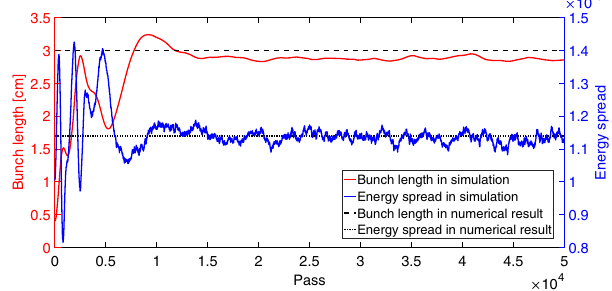
FIG. 6. Beam longitudinal parameters vary with the number of passes up to over 40000 turns, the red line stands for bunch lengths, while the blue one is energy spreads. The first dashed is the final bunch length derived from the bunch distribution numerically, and the second dashed is energy spreads calculated from the radiation integrals.